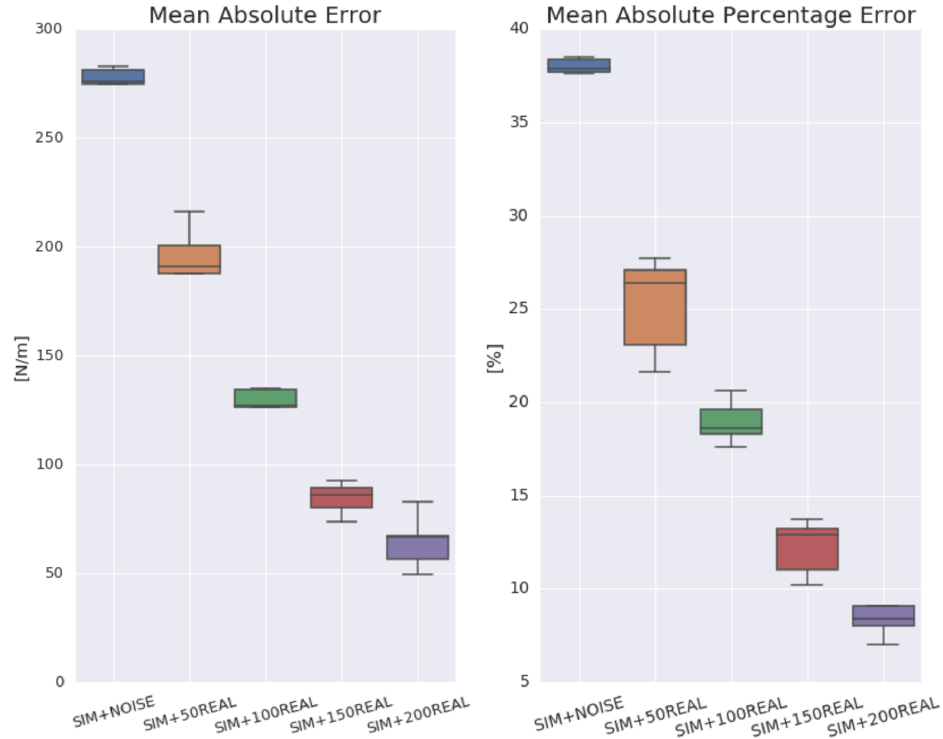
Figure 7. Results of MAE/MAPE from the testing on real-world data presented in the box plot. As the number of real data samples included in the training dataset increases, the test error decreases. Boxes represent consecutive experiments and consist of the five-number summary of the result (from the bottom of each box): minimum, first quartile, median, third quartile and maximum